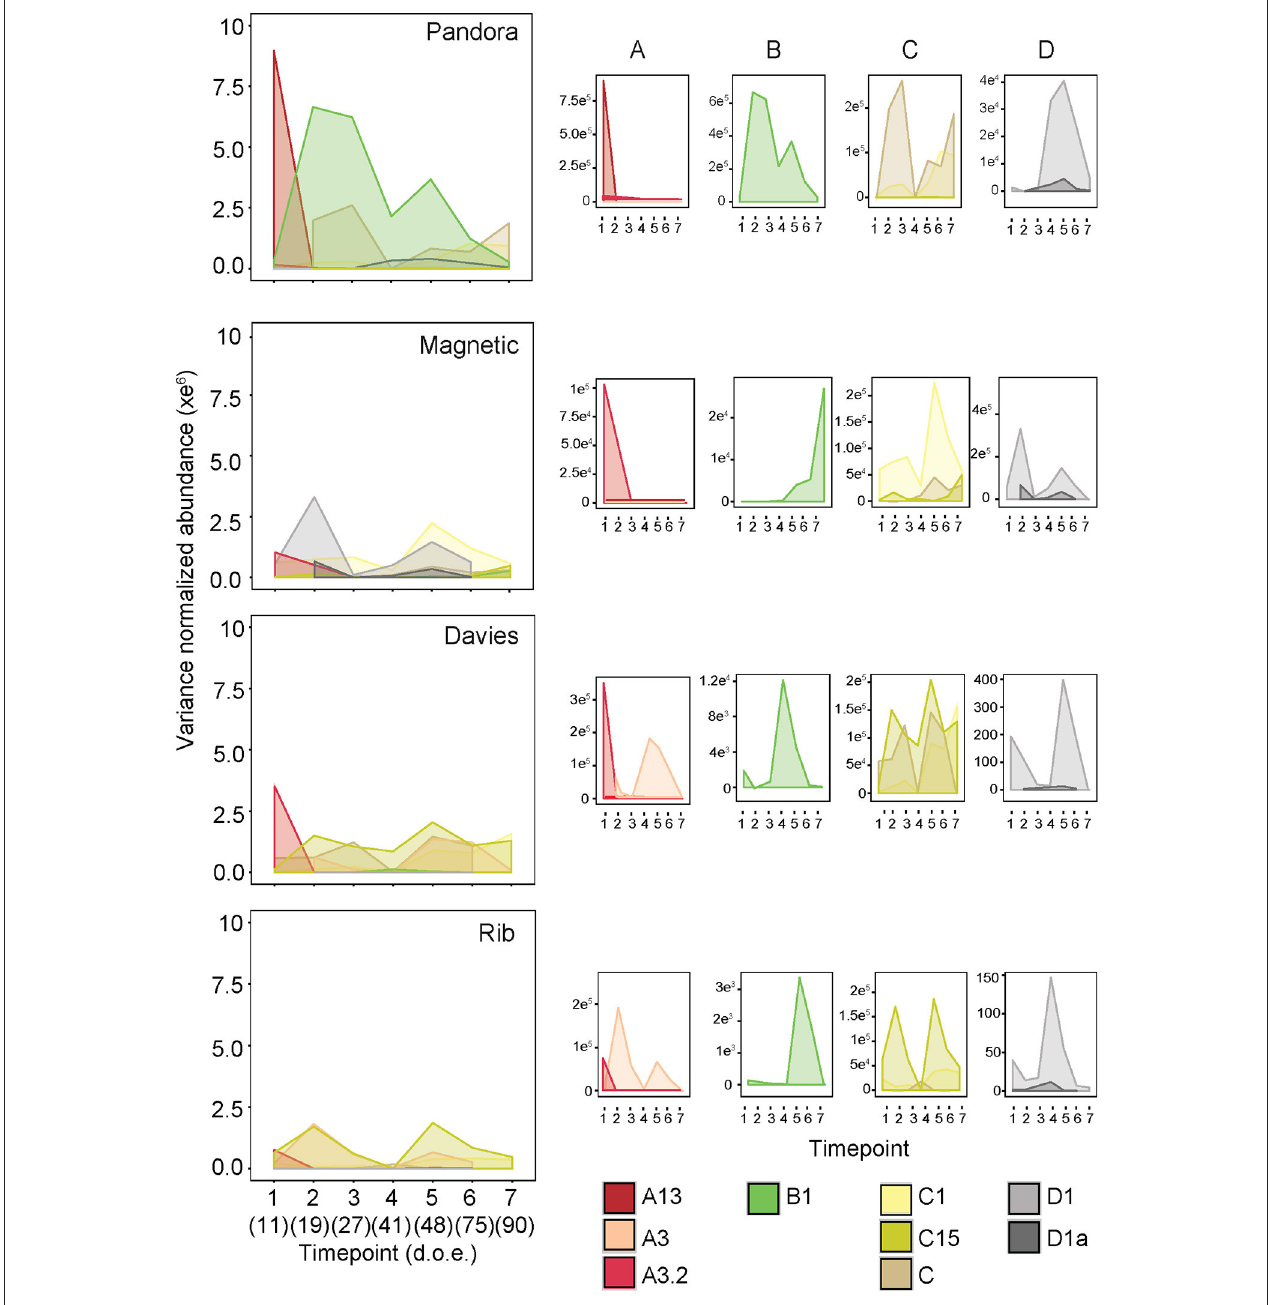
FIGURE 7 | Population dynamics of key Symbiodinium types in A. tenuis juveniles exposed to central sector sediments. Abundances of Symbiodinium types were variance normalized. Analyses were restricted to seven time points between day 11 and day 90 of sediment exposure (d.o.e.). The larger panels are all to the same scale, whilst the smaller panels (A–D) for each site have y-axes that are scaled to best show abundance dynamics for each Symbiodinium type. Colors represent nine key Symbiodinium types, whose abundances differed significantly among time points, as well as among sites.